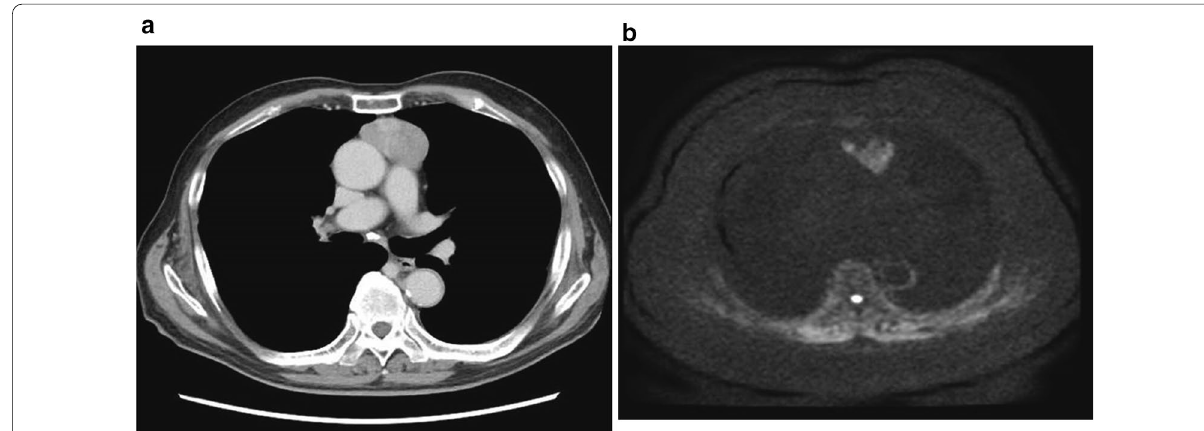
Fig. 1 Tumor appearance on diagnostic imaging. a Computed tomography showing a solitary tumor in the anterior mediastinum. b Diffusion-weighted magnetic resonance image showing a high-intensity signal in the tumor